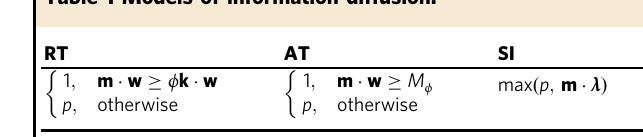
Table 1 Models of information